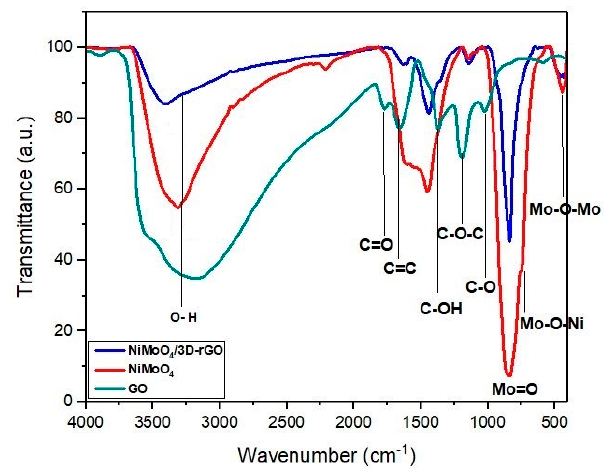
Figure 1. Fourier transform infrared spectrometry (FTIR) spectra of the graphene oxide (GO) sheets, NiMoO 4 nanoparticles (NPs), and NiMoO 4 /3D-rGO nanocomposite.